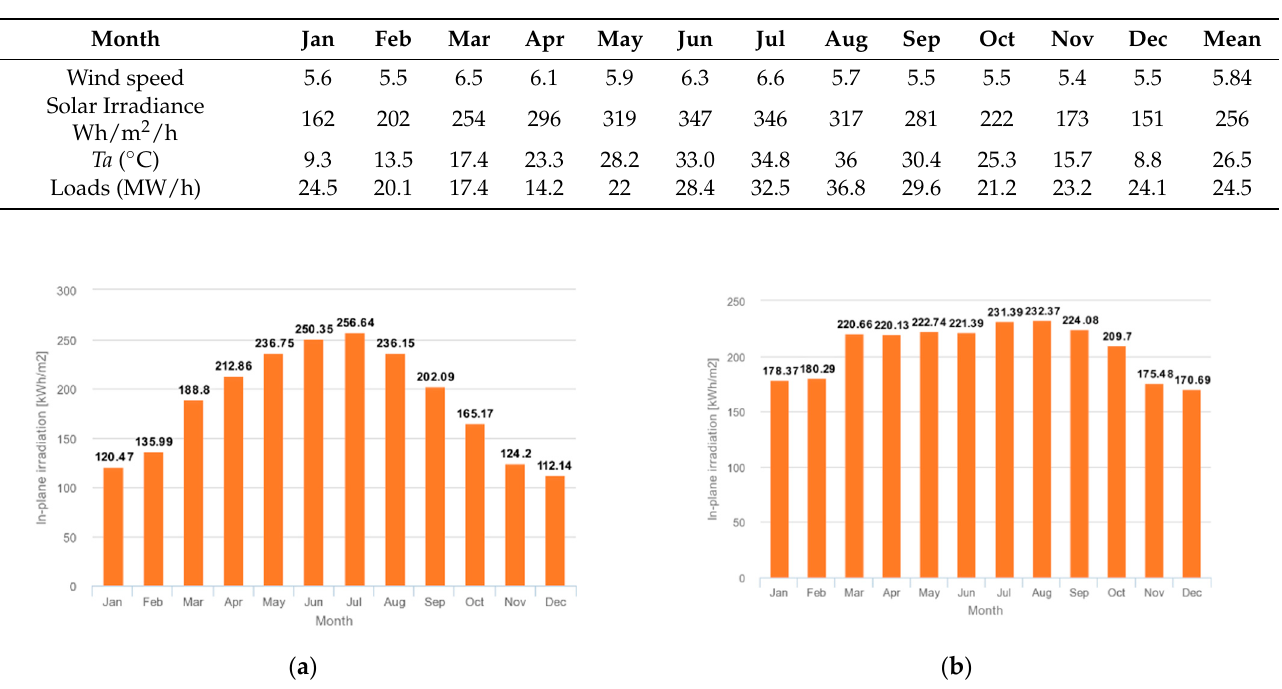
Figure 9. Monthly Solar Radiation on horizontal and 30° tilt angle in kWh/m 2 . ( a ): Horizontal plan. ( b ): On 30° tilt angle.